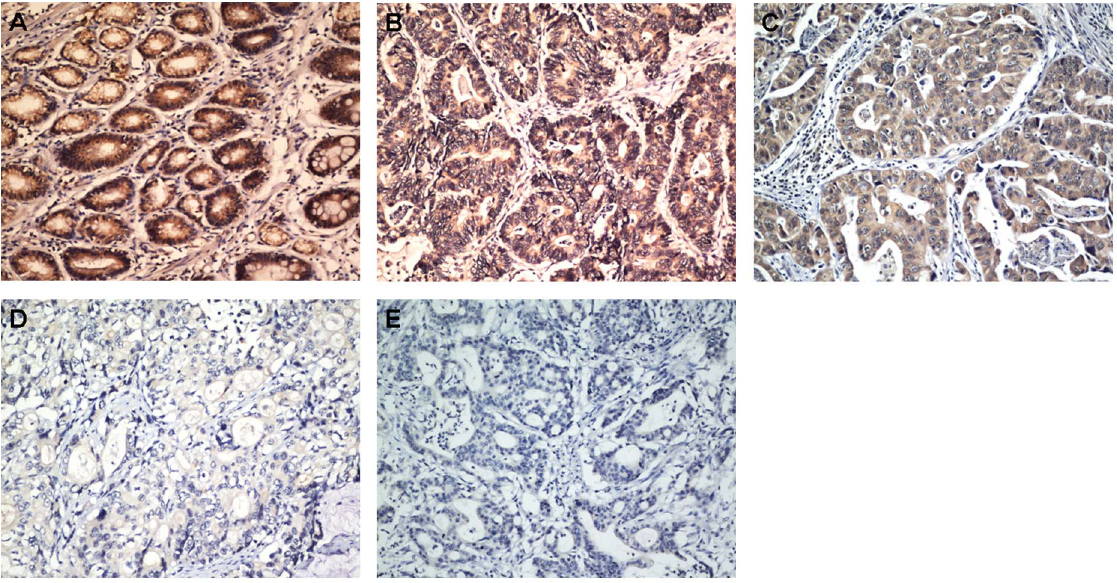
Figure 3. Immunohistochemical detection of the AZGP1 protein expression in gastric cancer and surrounding non-tumor tissues. (A) Normal gastric tissues, scored as AZGP1 ( +++ );(B) gastric cancer, scored as AZGP1 ( +++ ); (C) gastric cancer, scored as AZGP1 ( ++ );(D) gastric cancer, scored as AZGP1 ( + ); and (E) gastric cancer, scored as AZGP1 (-). Original magnification: A - D 6 200.